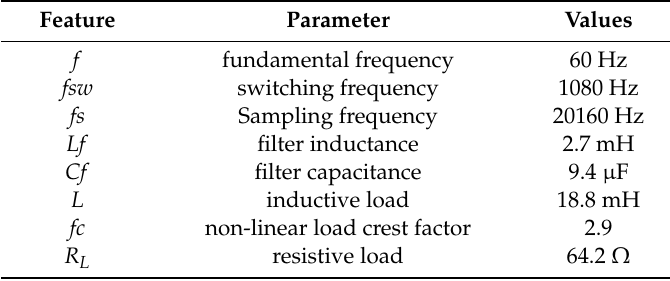
Table 1. Electrical features of the inverter and test